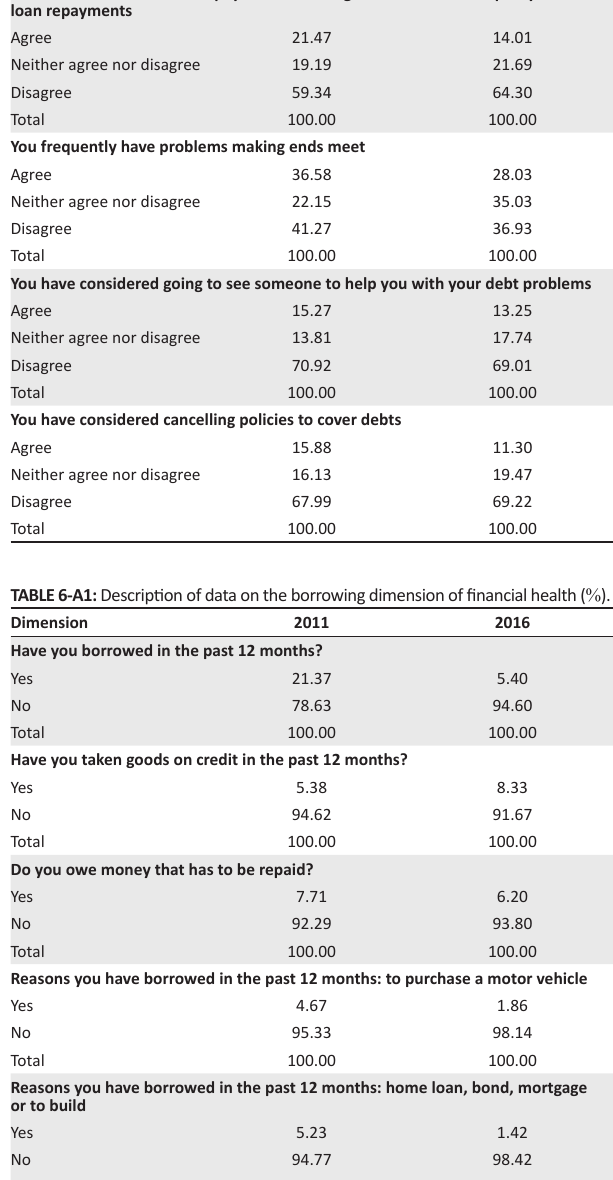
TABLE 5-A1: Description of data on the spending dimension of financial health ( % ). Dimension